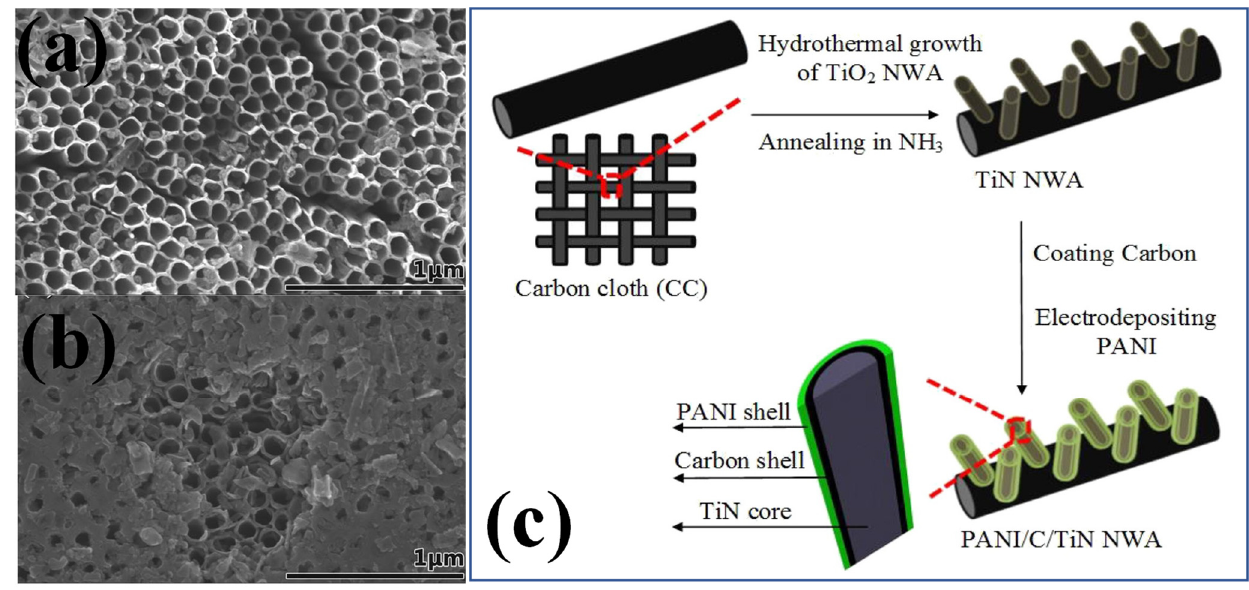
Figure 5. ( a ) The SEM images of the top view of TiN nanotubes and ( b ) PPy coated TiN nanotubes [47], reproduced with permission, copyright 2014, Royal Society of Chemistry. ( c ) The synthesis mechanism of PANI–C–TiN NWA grown onto CC substrate [70], reproduced with permission, copyright 2015,